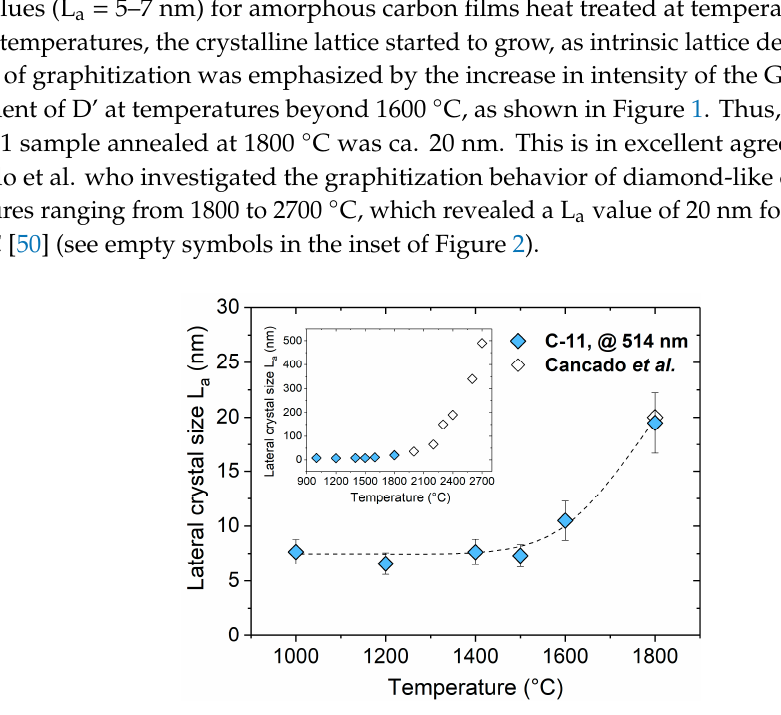
Figure 2. Evolution of the lateral crystal size L a in C-11 as a function of the treatment temperature. The open data points in the inset represent the work of Ref. [50], indicating the evolution of L a with the annealing temperature for diamond-like thin films.